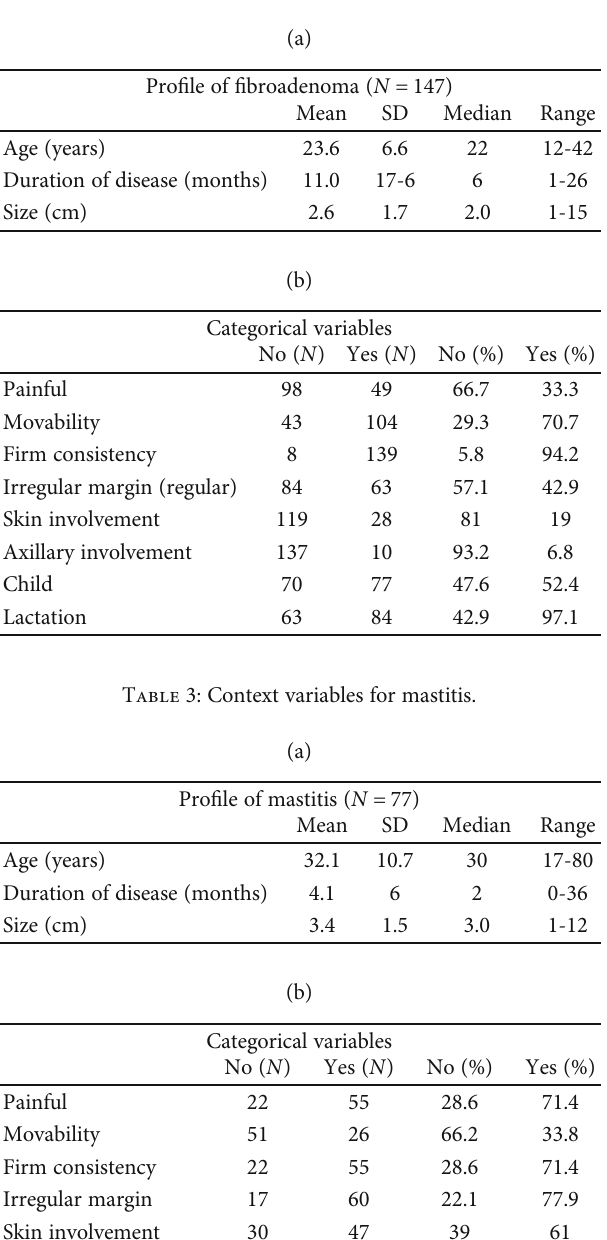
Table 2: Context variable of fi broadenoma.